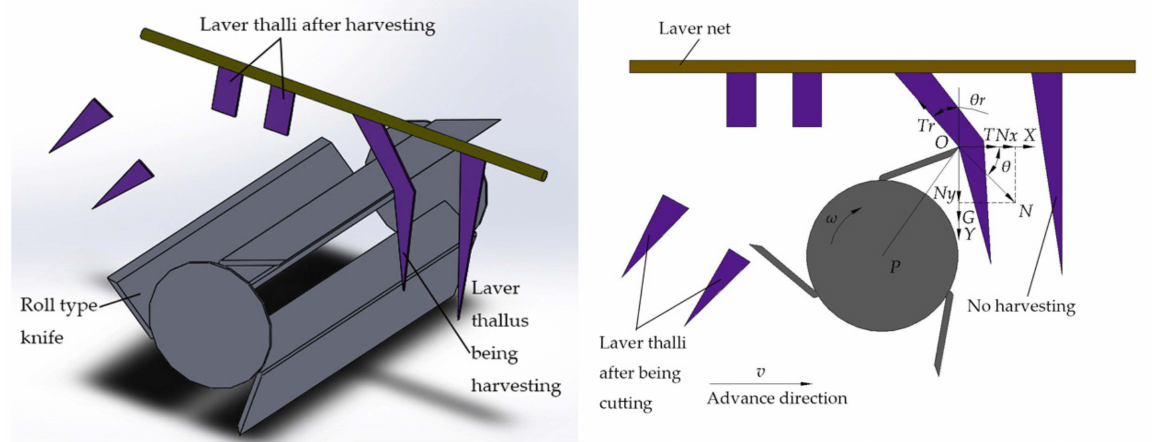
Figure 1. The force when roll-type knife cuts laver thalli [10]. P —roll center, O —origin of coordinates, ω —angle velocity, v —advance velocity, θ —cutting angle of revolution, θ r —scattering angle of laver thalli, X —advance direction of roll-type knife, Y —dangling direction of laver thalli, Tr —elasticity resistance force of laver thalli, T —resistance when roll-type knife acts on laver thalli, N —cutting force of roll-type knife, Nx —horizontal component force of N , Ny —vertical component force of N , G —weight of laver